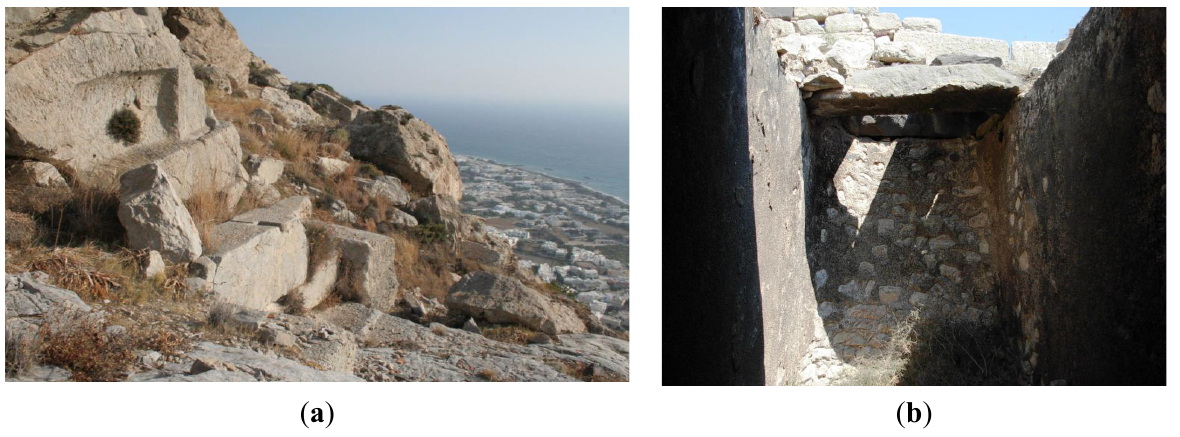
Figure 4. Cisterns on Santorini: ( a ) Collection and storage rainwater on Santorini: Structure for the collection of a spring water and ( b ) Inner view of an ancient cistern